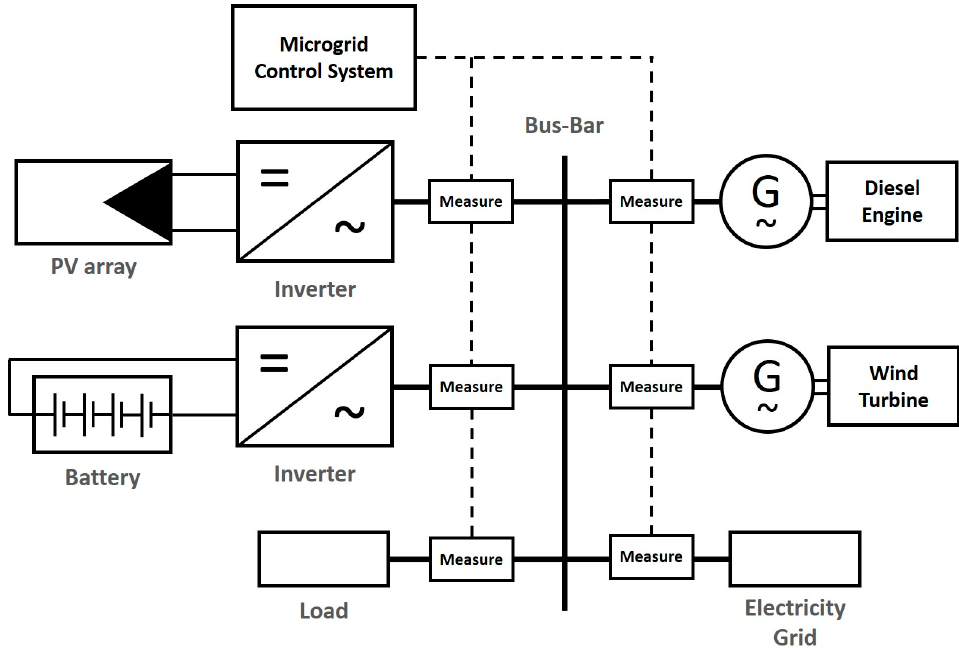
Figure 7. Schematic of the microgrid system.